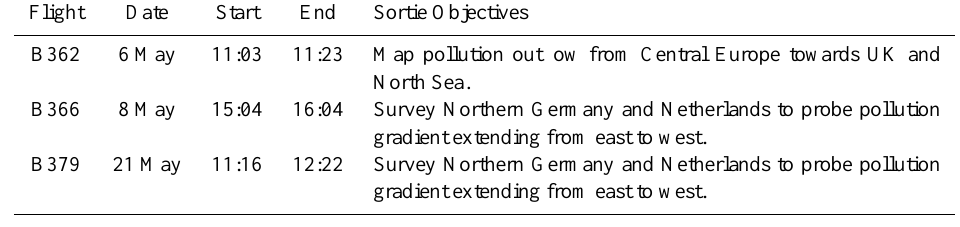
Table 1. Flight summary of the operations included in this study. All flights were conducted during 2008. Also included are the times when the BAe-146 operated in the vicinity of Cabauw.